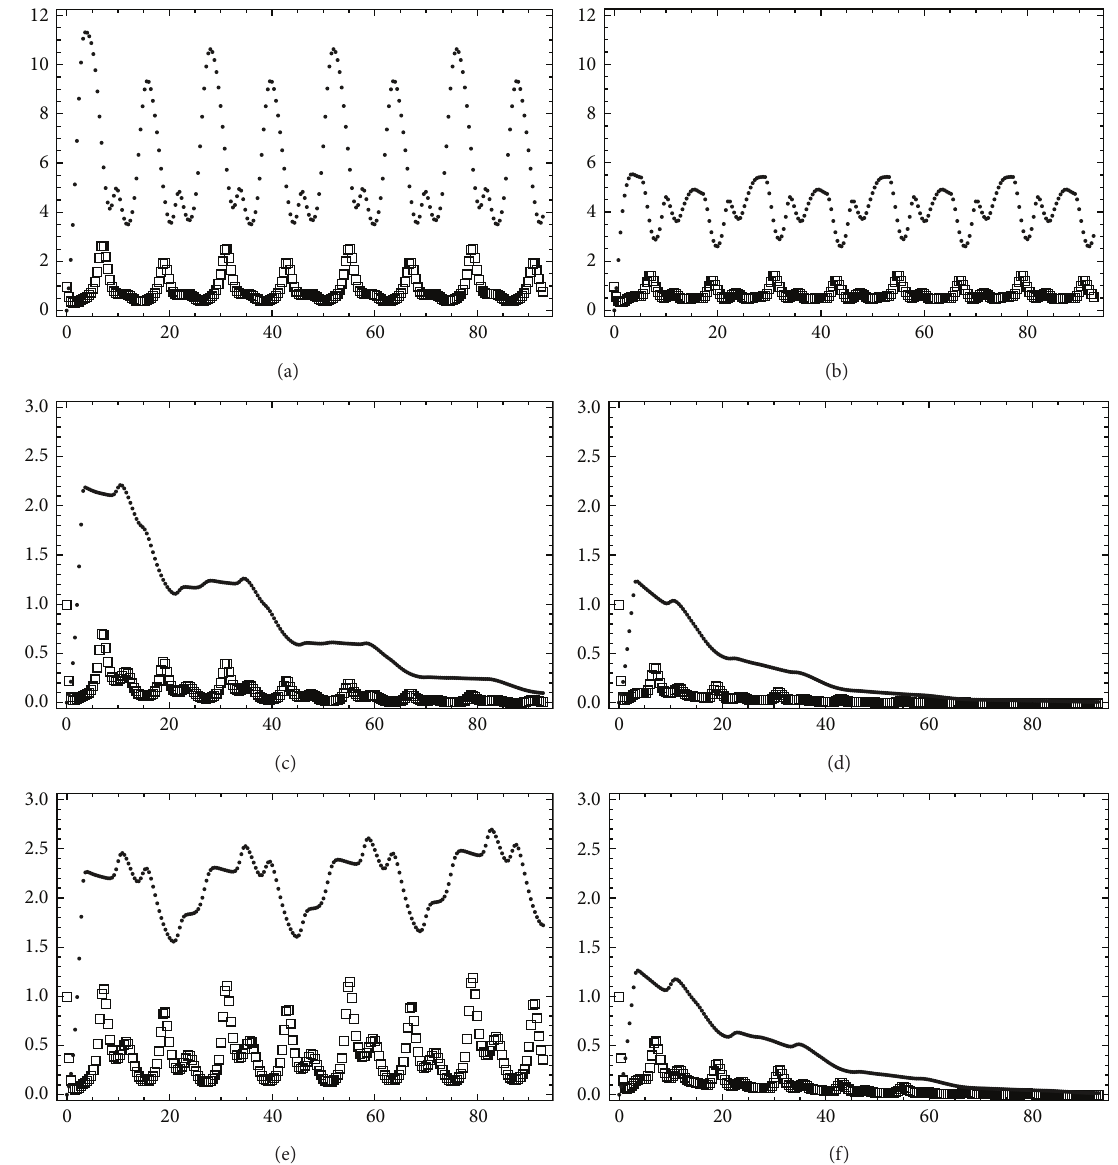
Figure 4: Comparison between uncontrolled and the controlled snails: a periodic solution ((a-b), 𝐴 = 1 , 𝐵 = 2.4 , and 𝑟 = 2.5 ), a solution tending to zero ((c-d), 𝐴 = 2 , 𝐵 = 0.2 , and 𝑟 = 3.8 ), and a changed case ((e-f), 𝐴 = 2 , 𝐵 = 0.2 , and 𝑟 = 2.5 ), where square is 𝑥(𝑡) , dot is 𝑦(𝑡) , = 0 , and 𝑥 (𝜃) = cos (𝜋𝜃/10) 𝑦 0 0